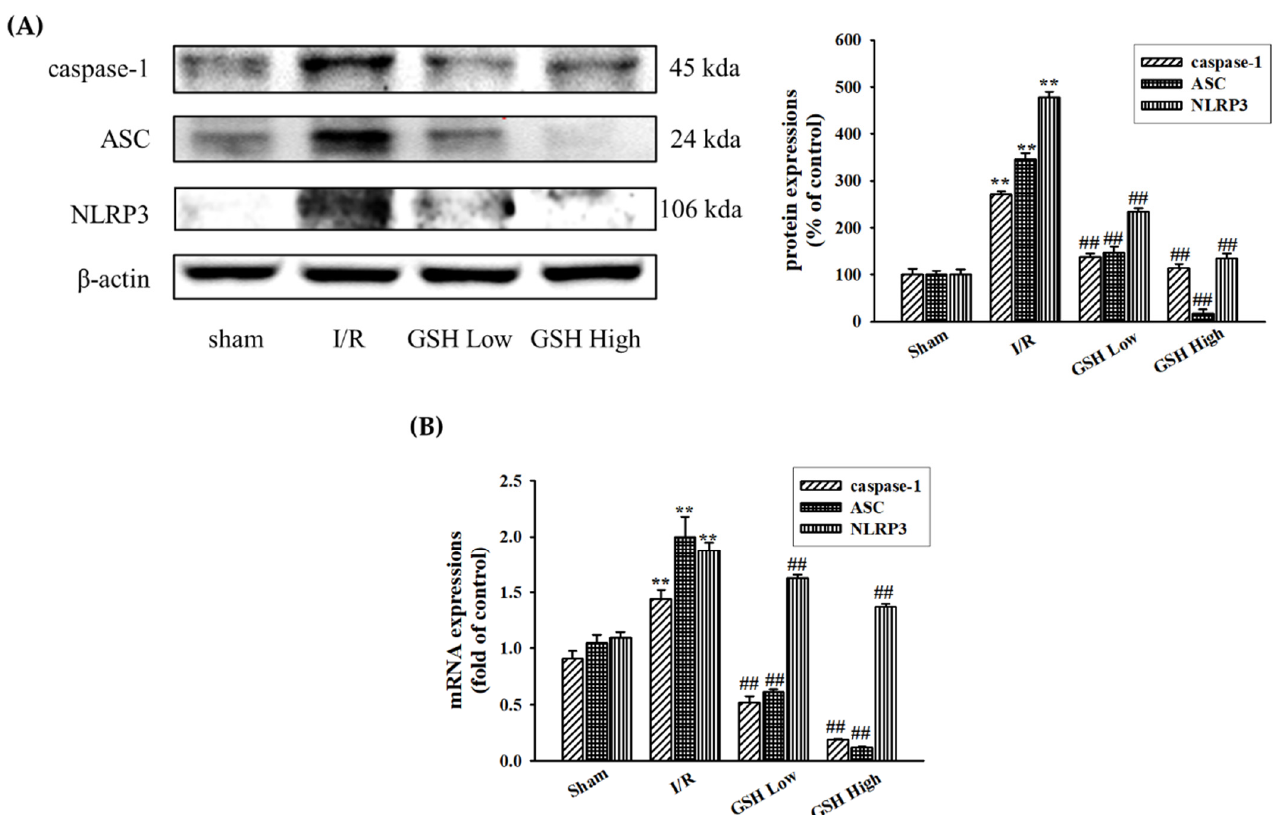
Figure 6. Effects of GSH on NLRP3 inflammasome in kidney. Protein expressions of inflammasome such as caspase-1, ASC, and NLRP3 were analyzed by Western blot analysis ( A ). Relative mRNA expression was analyzed by real-time RT-qPCR ( B ). Data are presented as means ± SE ( n = 3). ## p < 0.01 vs. sham group; ** p < 0.01 vs. I/R group.